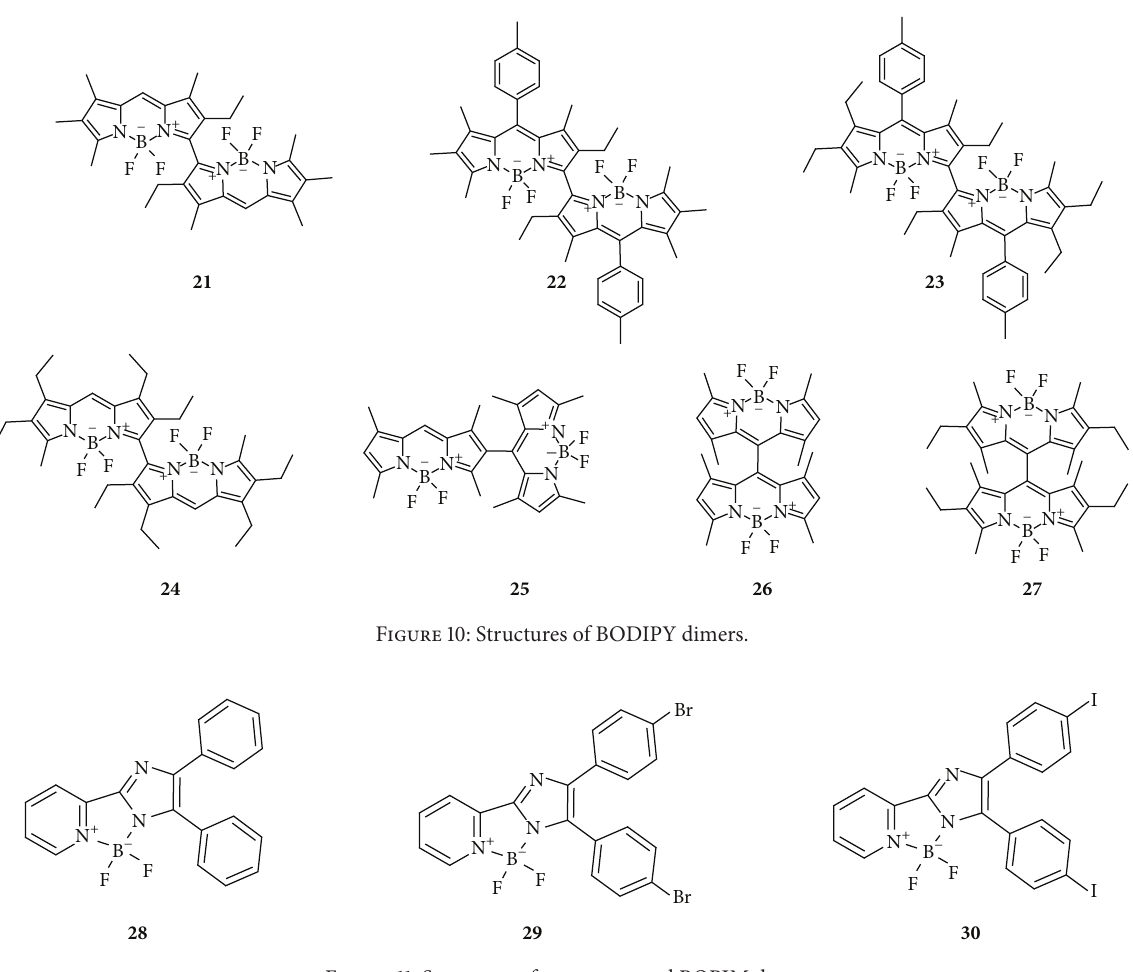
Figure 11: Structures of nonaggregated BOPIM